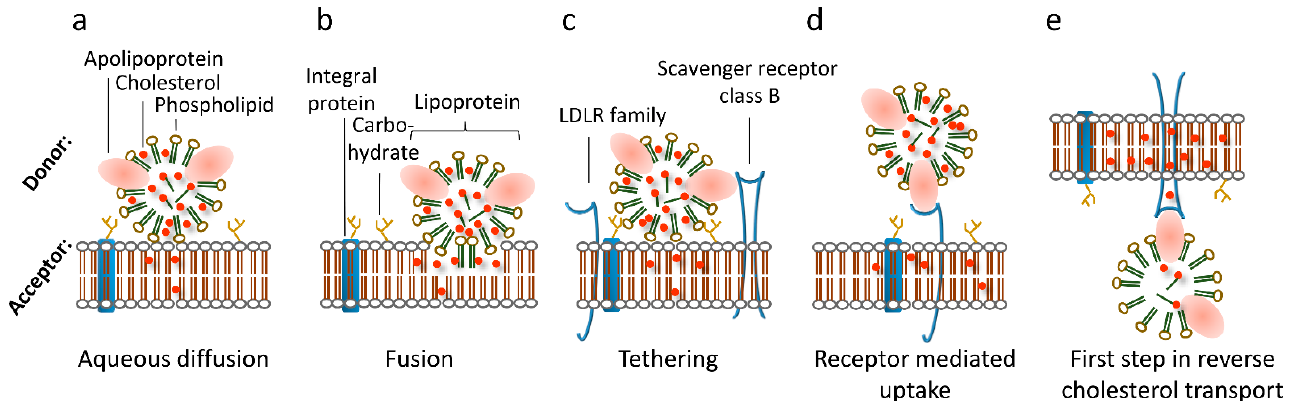
Figure 1. Modes of lipoprotein-mediated cargo transfer to/from cells. ( a ) Aqueous diffusion transfers cholesterol from lipoprotein particles to membranes in close proximity by passing the aqueous layer between the lipid membranes. ( b ) Fusion of lipoprotein particles yields transfer of all components of the lipoprotein particle. ( c ) Tethering function of receptors or the glycocalyx mediates aqueous diffusion. ( d ) Receptor-mediated endocytosis occurs by specific binding of certain apolipoproteins by their respective receptors and subsequent endocytosis. ( e ) Cholesterol efflux via ABC cholesterol transporters removes excess cholesterol from the cell to cholesterol-poor HDL particles.